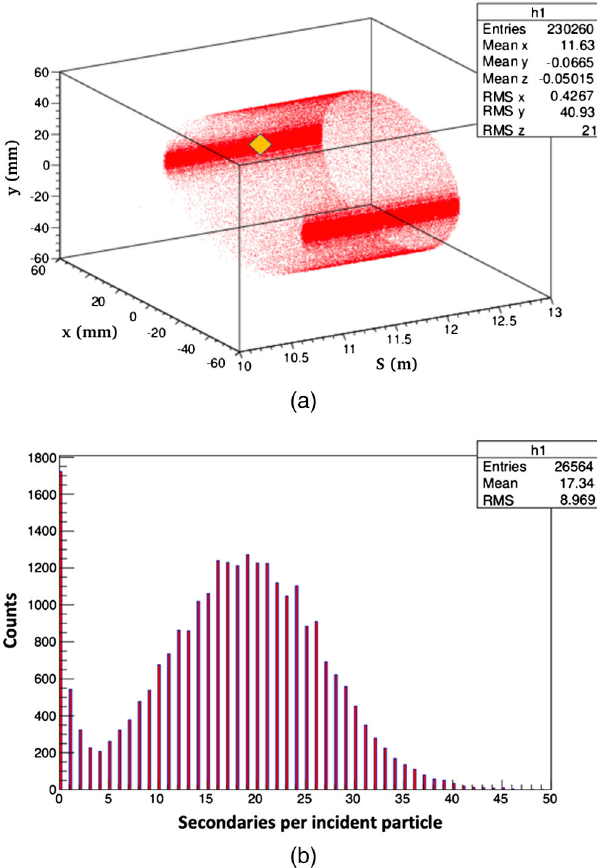
FIG. 8. (a) The 3D distribution of the charged secondaries resulting from the interaction of the subset of the lost Touschek positrons with the 6 mm Cu cylinder beam pipe in the drift where we placed our DS (represented by a yellow diamond) and (b) their number per incident particle.